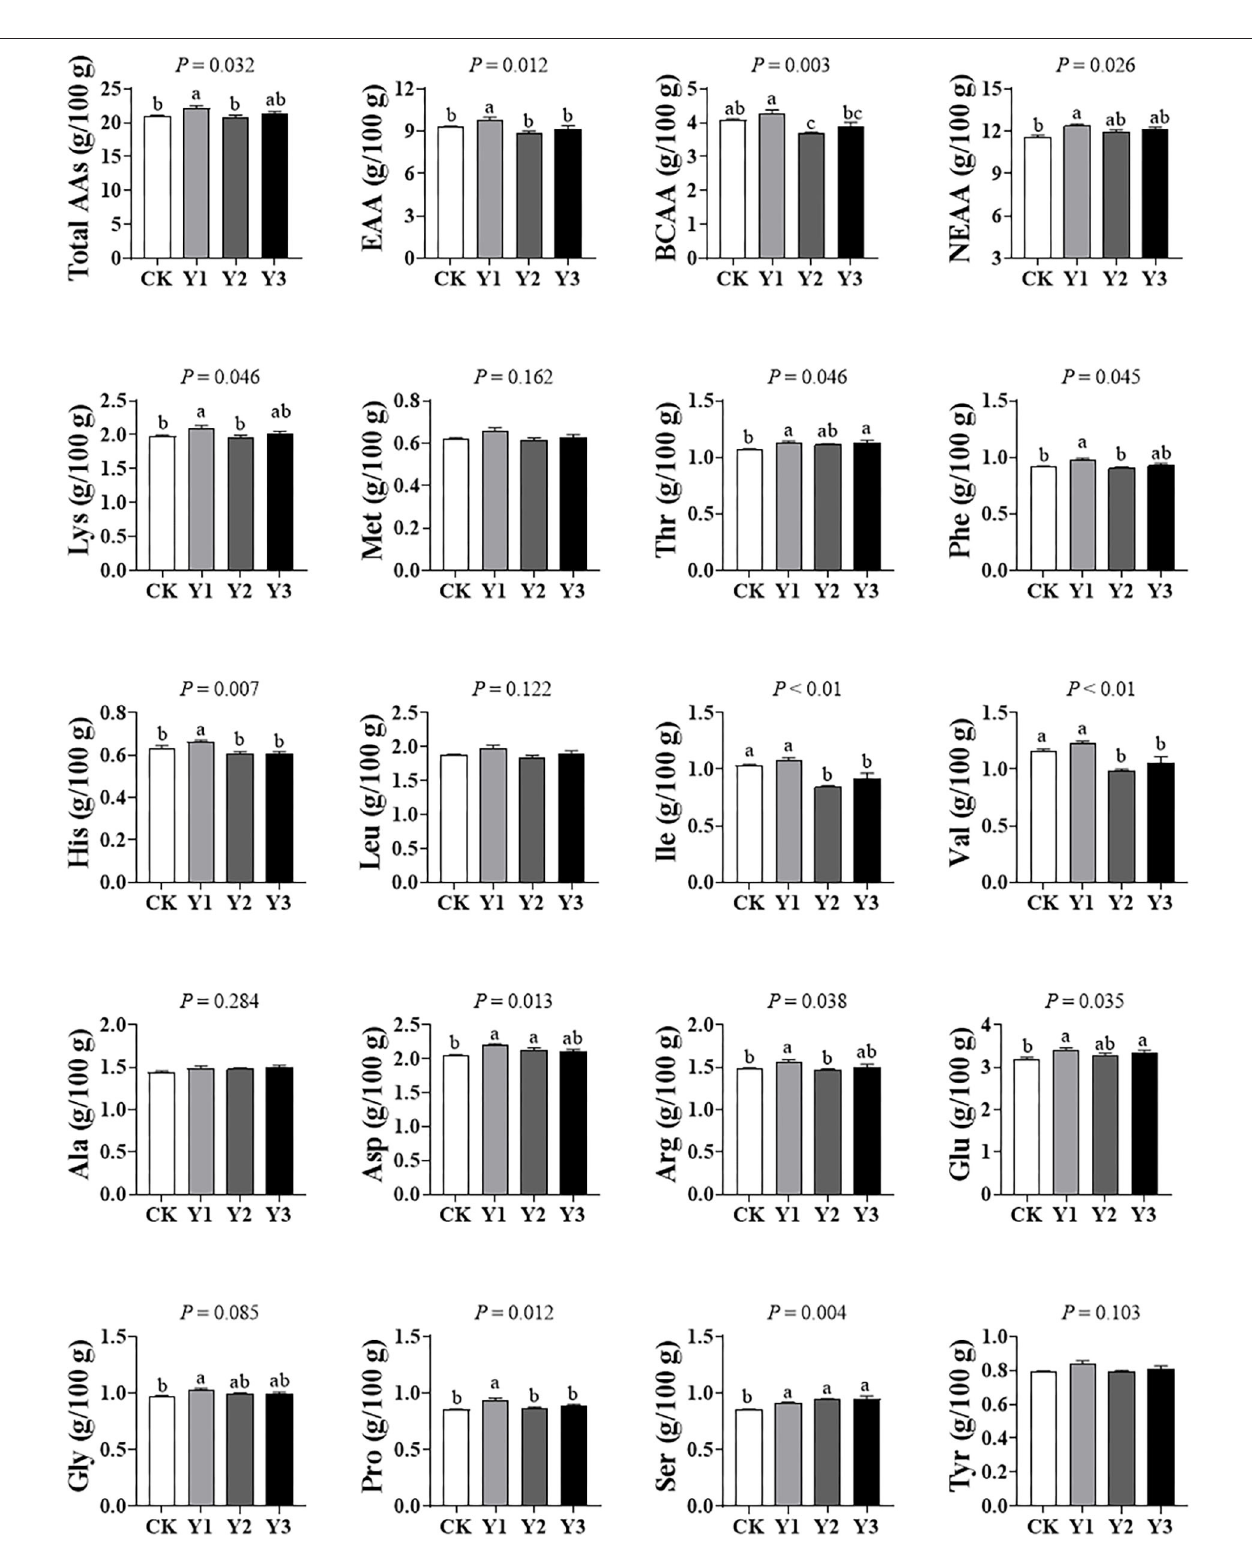
FIGURE 5 | Effects of dietary AOE on meat free amino acid composition in breast muscle of Jiaji ducks. EAA = lysine (Lys) + methionine (Met) + threonine (Thr) + phenylalanine (Phe) + histidine (His) + leucine (Leu) + isoleucine (Ile) + valine (Val). BCAA = Leu + Ile + Val. NEAA = alanine (Ala) + aspartate (Asp) + arginine (Arg) + glutamate (Glu) + glycine (Gly) + proline (Pro) + Serine (Ser) + tyrosine (Tyr).